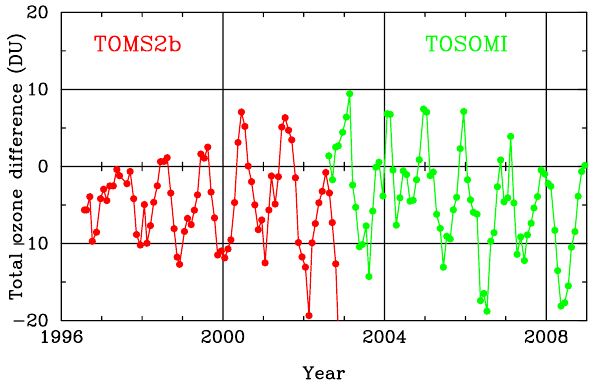
Fig. 1. Monthly averaged anomalies for the overpass data at the ground station De Bilt (5.18 ◦ E, 52.1 ◦ N) in the Netherlands. The anomalies for TOMS2b (red) correlate with effective ozone temper- ature, while the anomalies for TOSOMI (green) correlate with solar zenith